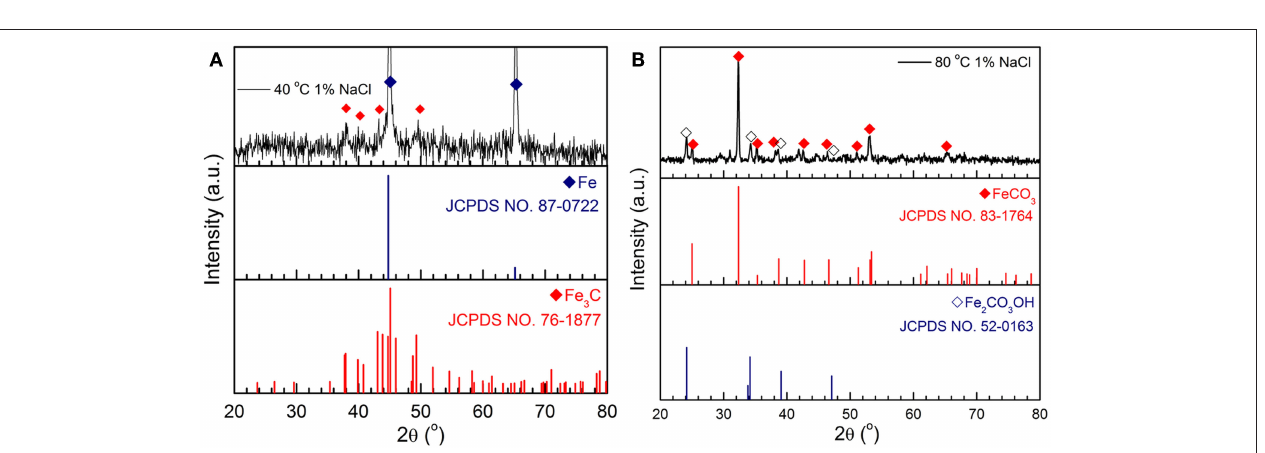
observed and no crystalline particles formed on the sample surfaces. In addition, more Fe 3 C accumulated on the sample higher corrosion rate observed at higher temperature (40